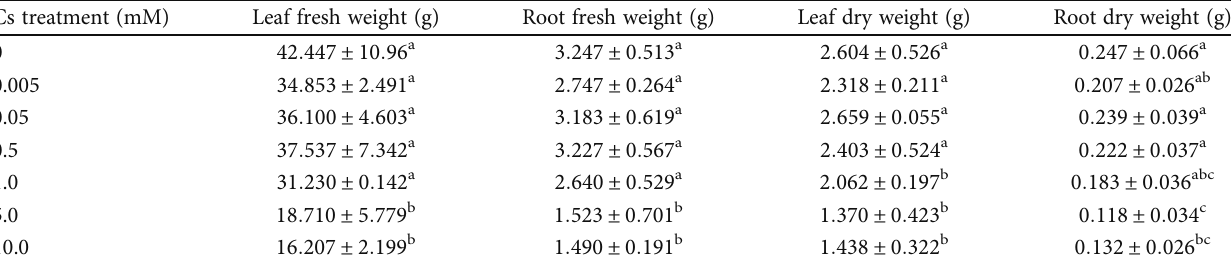
Table 1: E ff ects of exposure to Cs + on biomass of